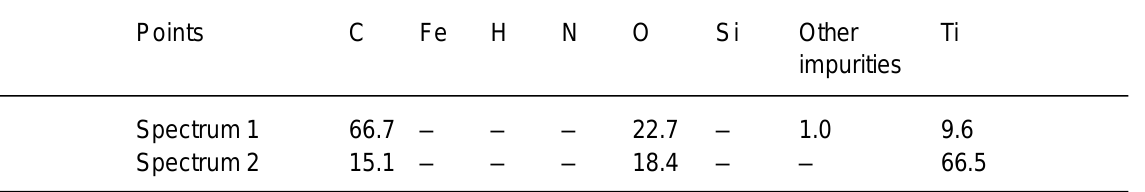
Table 2. Chemical composition of the points shown in Fig. 7c (wt. %).